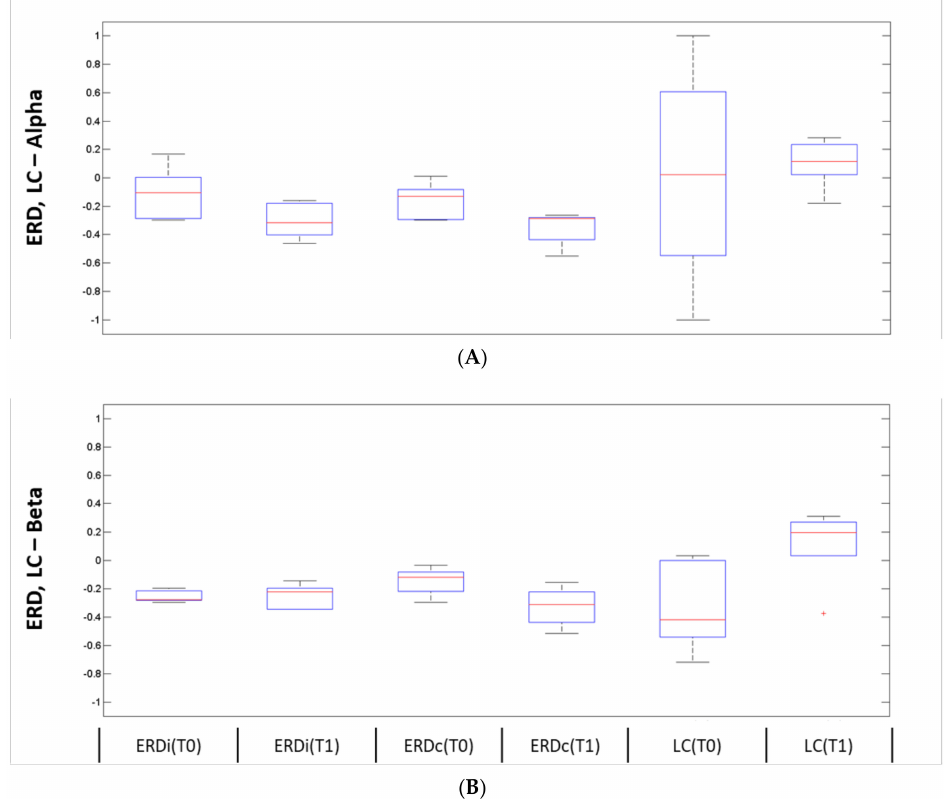
Figure 7. Distributions of ERDi, ERDc and LC, before (T0) and after (T1) the robotic rehabilitation, are shown for the alpha ( A ) and beta ( B ) bands. The central line indicates the median, while the lower and upper extremities of the boxes represent the 25th and 75th percentiles, respectively. The whiskers comprise all the data points distribution except the outliers, which are plotted separately using the ‘+’